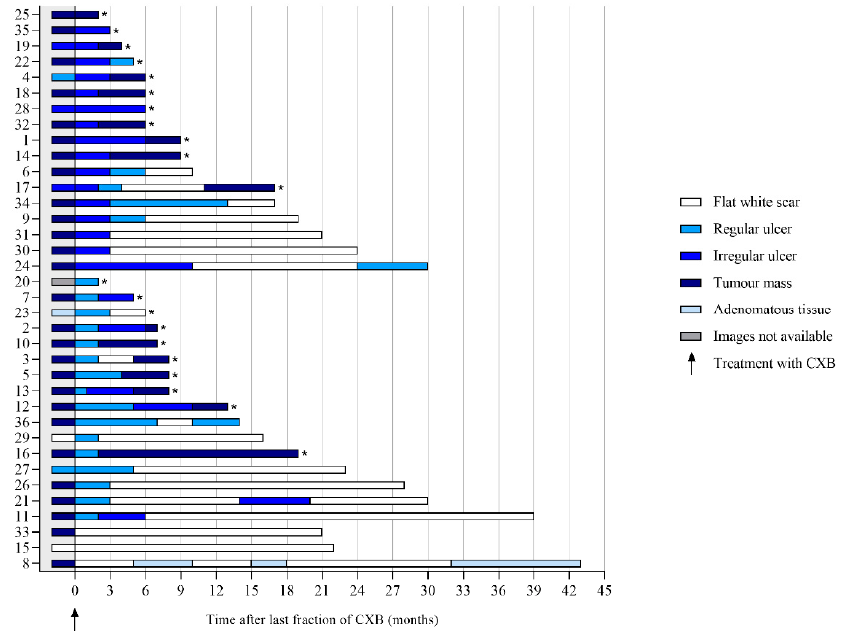
Figure 4. Features on endoscopy prior to and during follow ‐ up after contact X ‐ ray brachytherapy per patient. * Patients with histopathological confirmation of residual tumor.